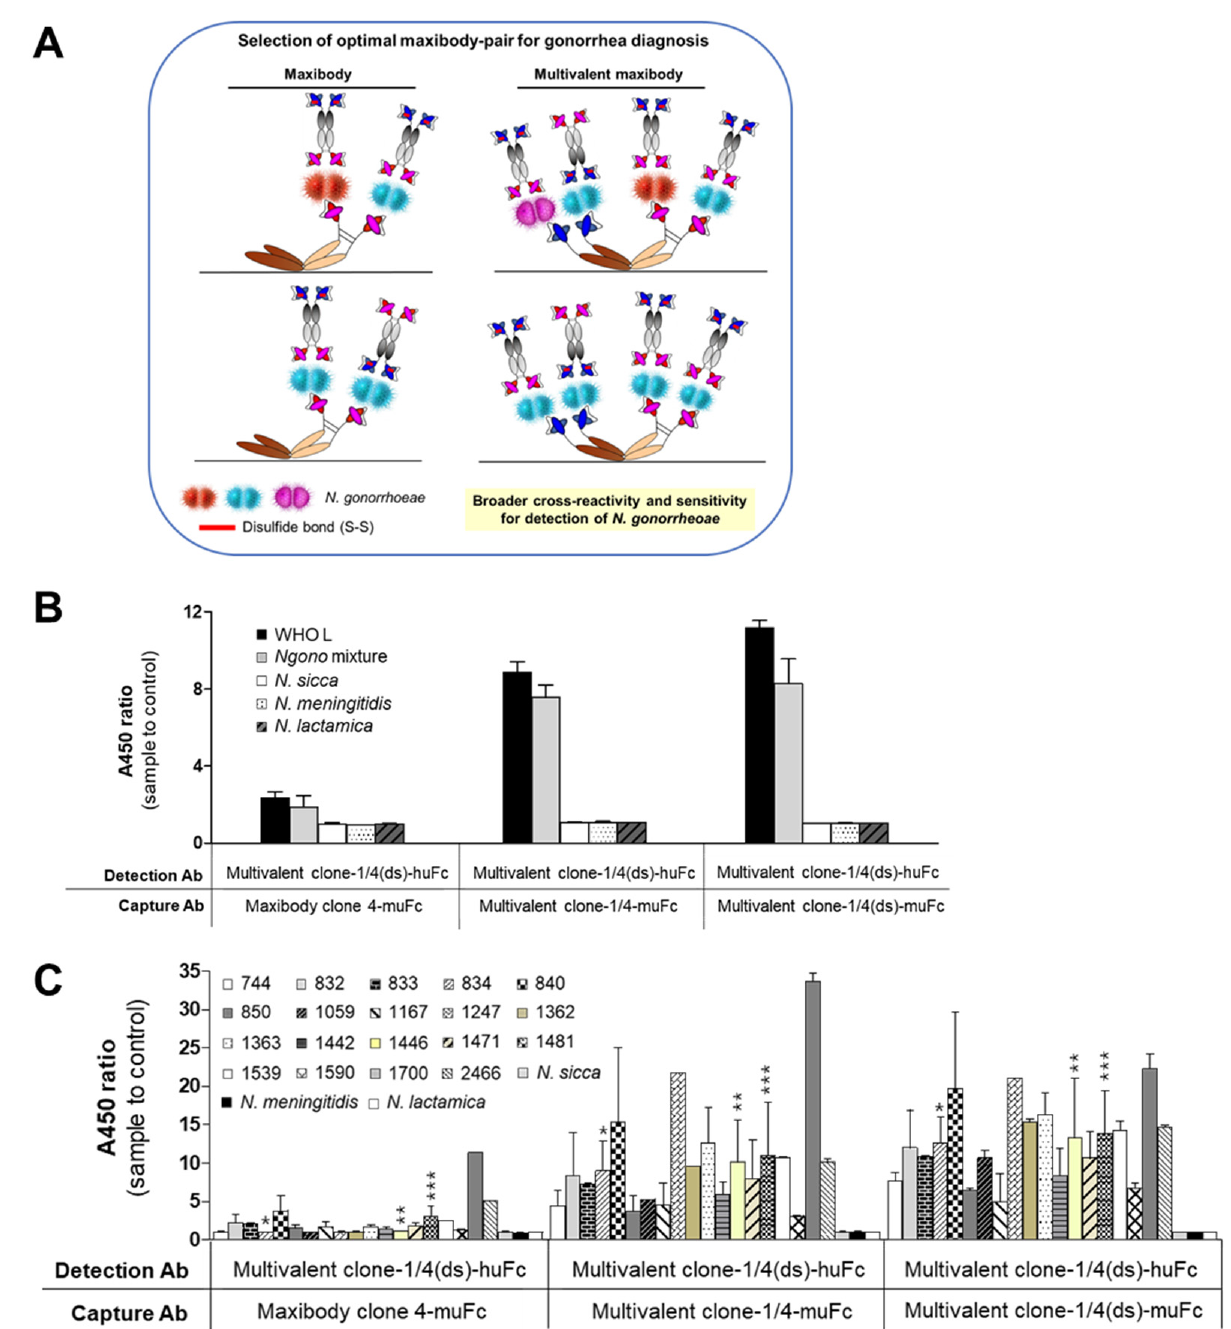
Figure 5. Analysis of the optimal maxibody pair for diagnosis. ( A ) A schematic presentation of sandwich ELISA for determining the optimal combination of capturing and detecting maxibodies for gonorrhea. Clone 4 maxibody containing the muFc domain, and multivalent maxibodies (Clone-1/4-muFc and Clone1/4(ds)-muFc) were used to capture N. gonorrhoeae . Multivalent Clone1/4(ds)-huFc maxibody detected the antigen bound to the capturing maxibody. ( B ) Identification of the optimal capturing maxibody using the WHO L reference strain and the mixture of N. gonorrhoeae isolates. N. meningitidis , N. lactamica , and N. sicca were used as controls for irrelevant Neisseria strains. ( C ) A broad-spectrum of patient-derived N. gonorrhoeae isolates was used as antigens for the antibodies. Multivalent clone-1/4(ds)-huFc was used as the detecting maxibody in conjunction with HRP-conjugated anti-huFc antibody. The A450 value obtained in the absence of antigen was used to determine the A450 ratio values expressed as the mean ± standard deviation (SD) of three independent experiments. The clinical isolates that were undetected by maxibody Clones 1 or 4 are indicated: Nos. 1481 (***), 834 (*), and 1442 (**). 4. Conclusions The increased specificity and affinity of the antibody for its antigen is a desirable feature of reagents in immunological method-based POCTs. Recently, the use of an an- tibody tagged with alkaline phosphatase in conjunction with thionicotinamide-adenine dinucleotide (thio-NAD) for developing a sensitive immunoassay has been reported for the diagnosis of mycobacterium tuberculosis [52]. The multivalent maxibody platform, scFv-Fc-scFv, represents an excellent option for diagnosing gonorrheal infections.